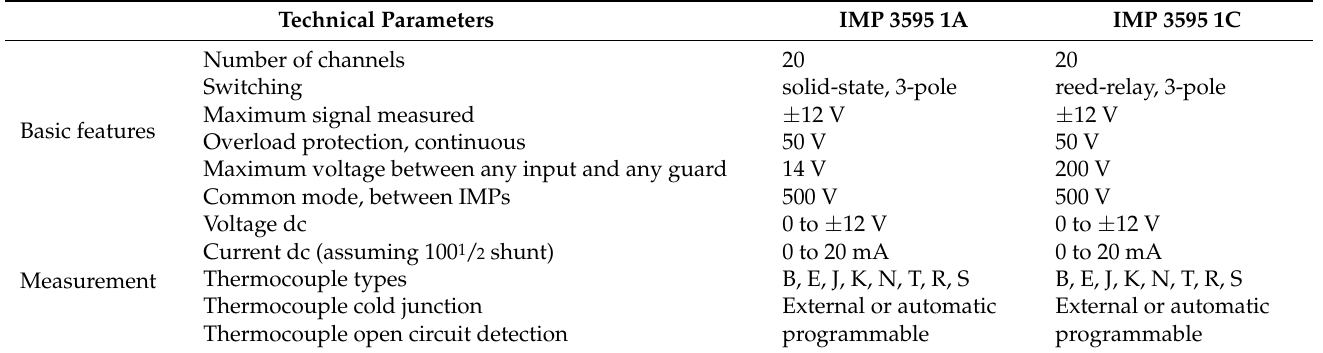
Table 4. Technical features of the IGBT